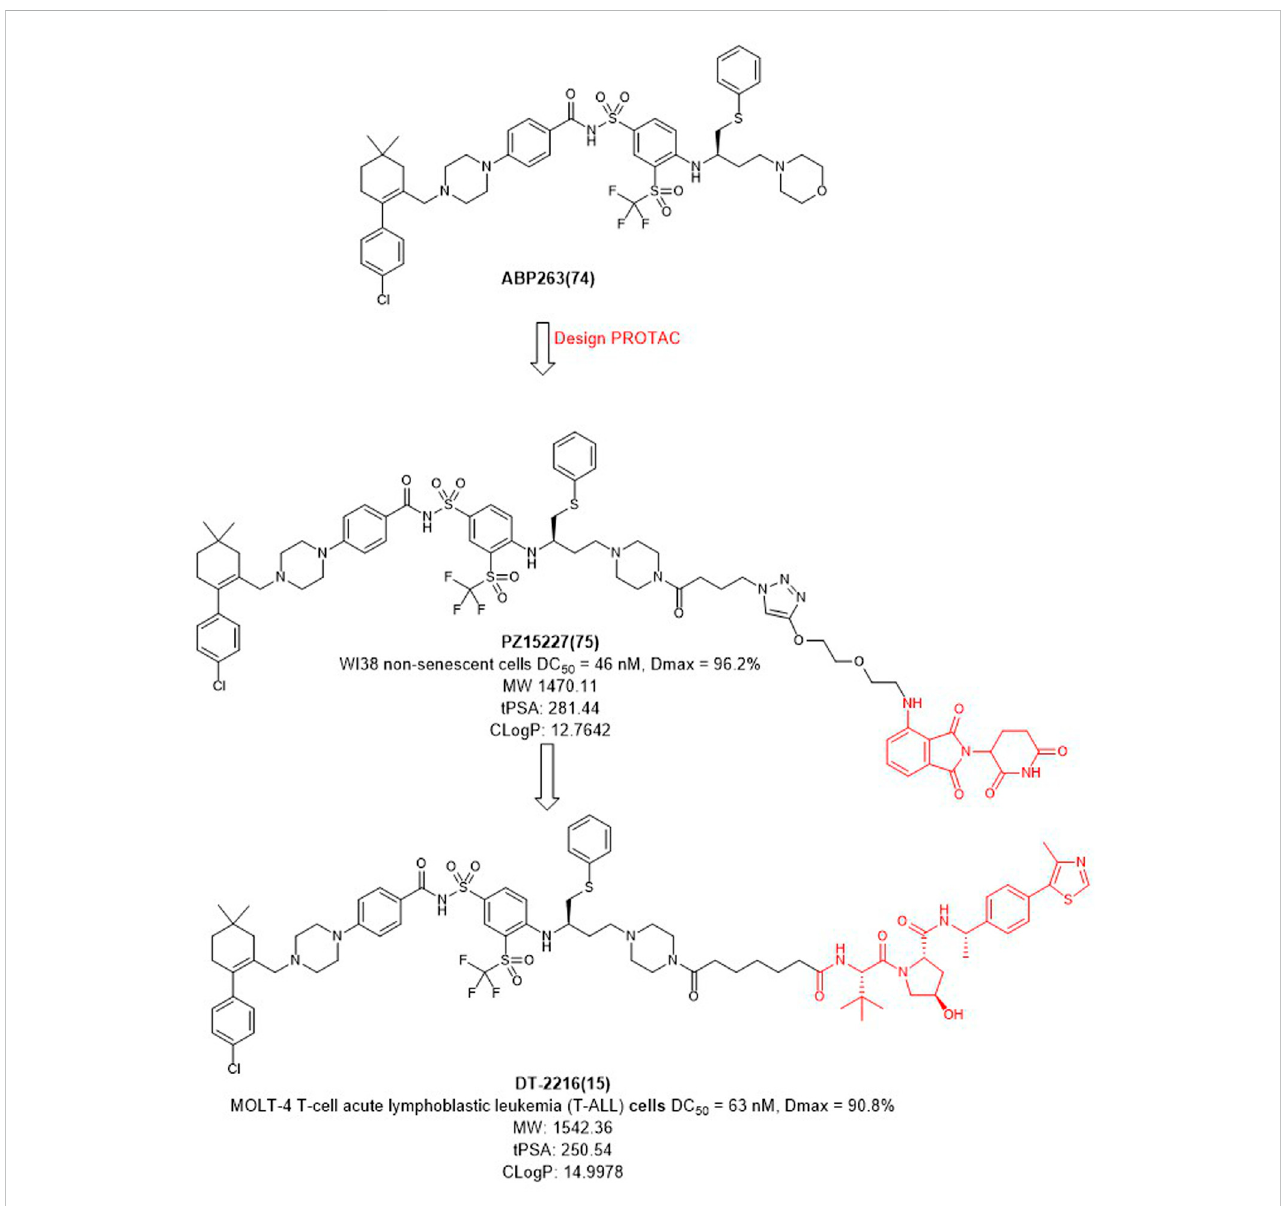
FIGURE 9 Design and optimization of BCL-X L